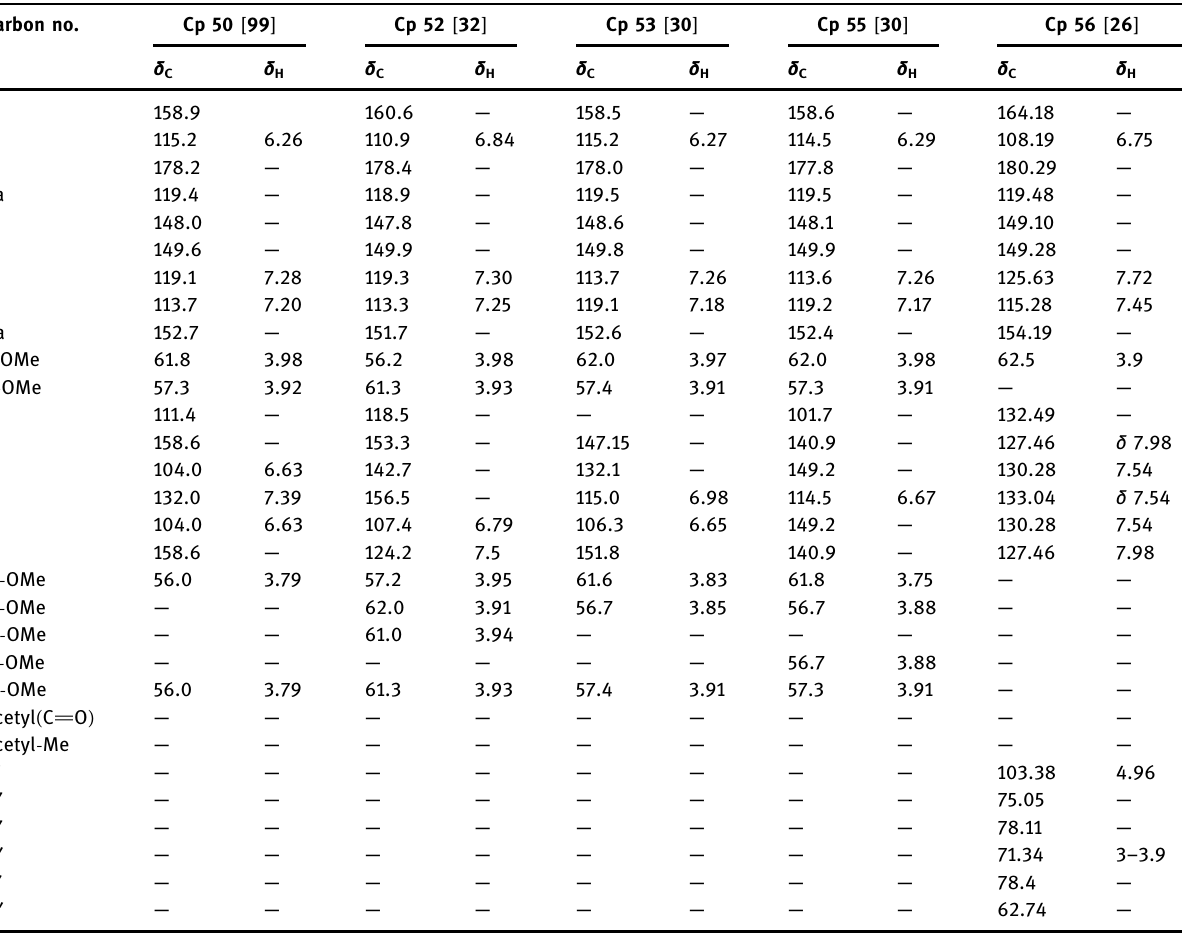
Table 16: 13 C and 1 H NMR chemical shift data ( δ , ppm ) of fl avonoids isolated from genus Casimiroa Carbon no.